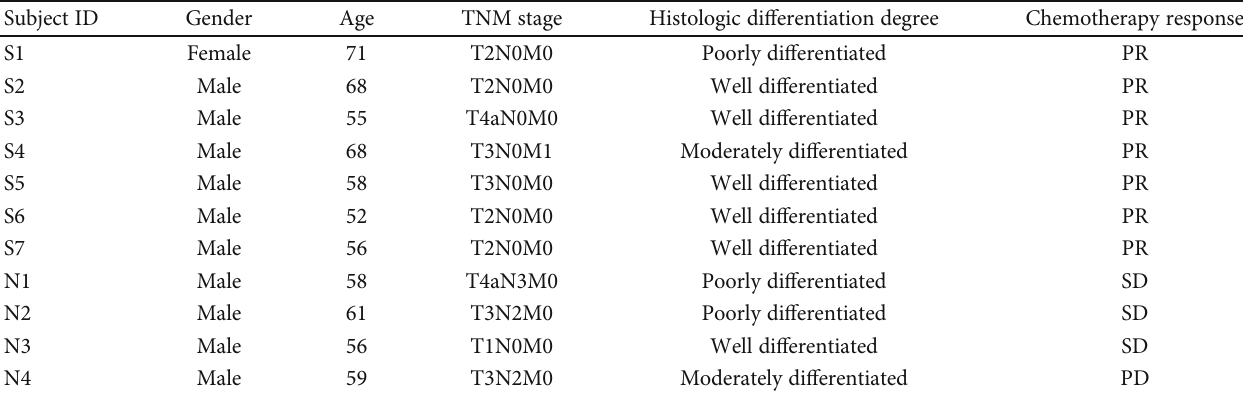
Table 2: Clinical data of HSCC patients for GSE85607.